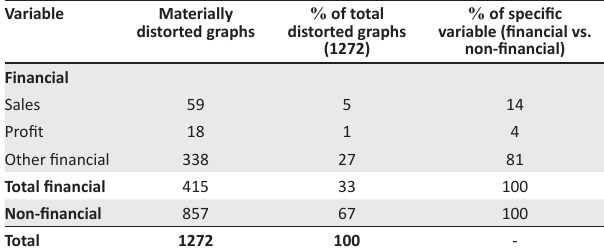
TABLE 6: Analysis of distortion per